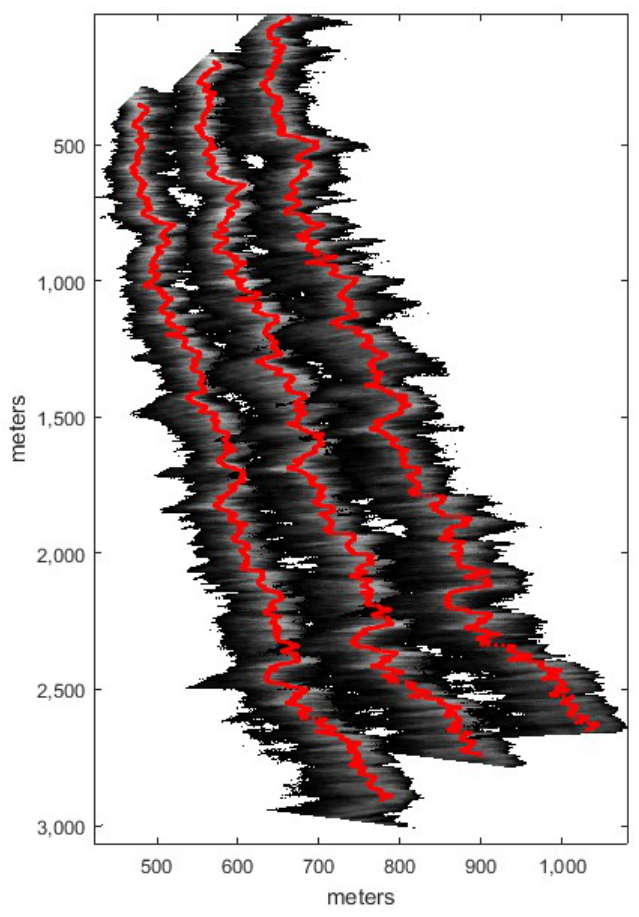
Figure 4. Three consecutive swaths over the same Uranine dye plume overlaid on one image. Greyscale shows the intensity of the Uranine dye signal, red dots follow the centerline of the plume. Horizontal and vertical axes correspond to relative Easting and Northing in meters.